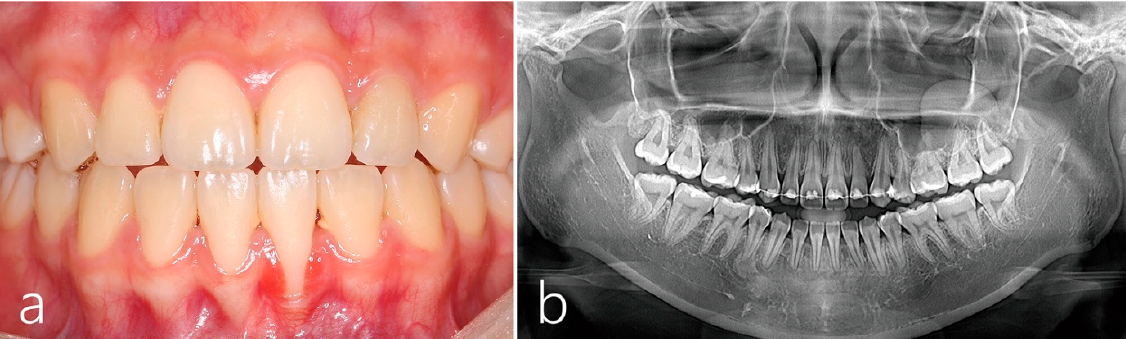
Figure 1. ( a ) Clinical finding 2 years after orthodontic treatment showed gingival recession in the left lower central incisor with a thin periodontal biotype. The roots of lower incisors were slightly labially protruded, and the interdental areas were relatively depressed. ( b ) Root resorption and interdental bone loss of lower incisors were observed on panoramic radiography at 2 years after orthodontic